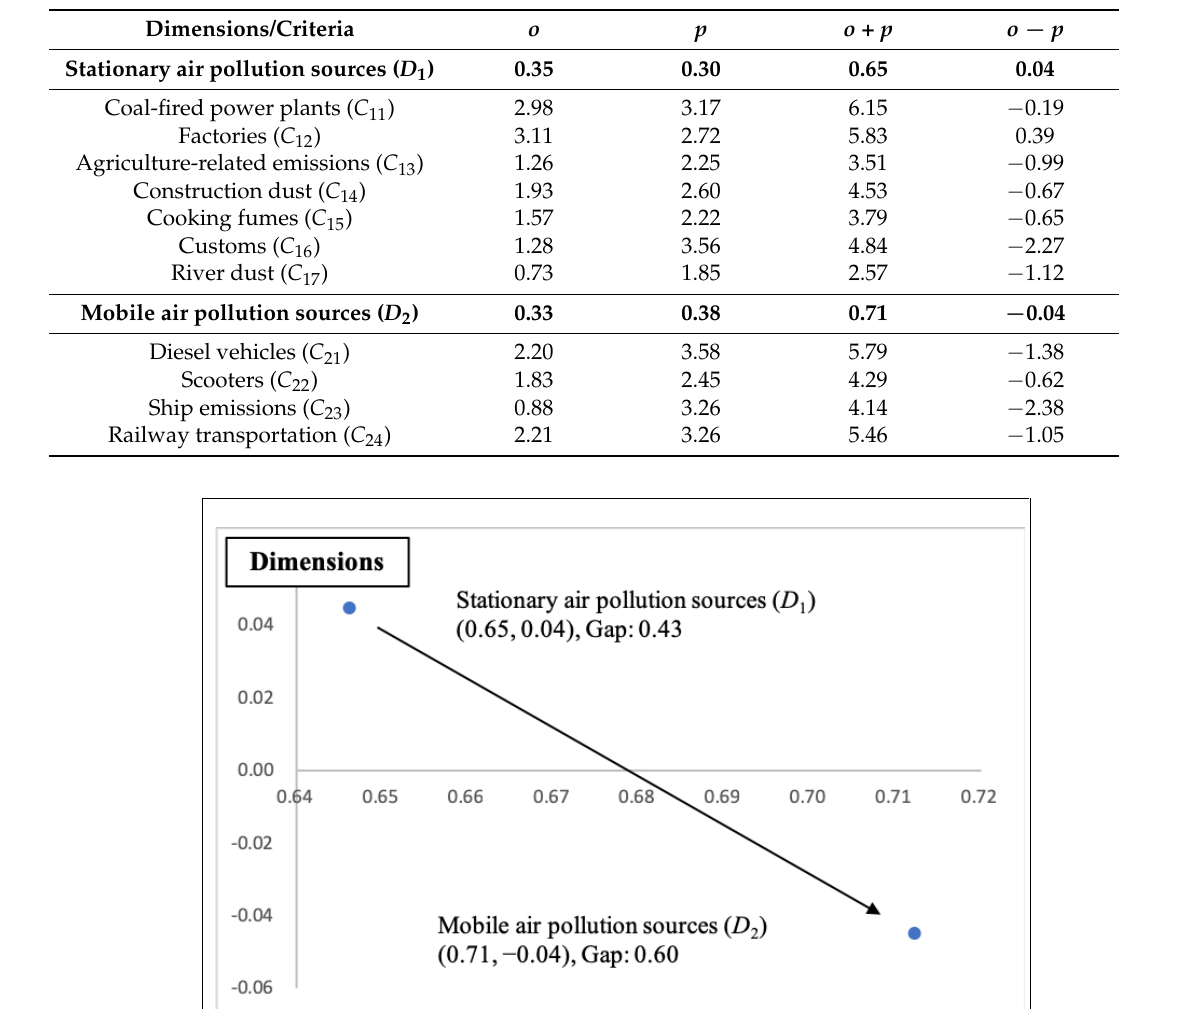
Table 2. Sum of influences given and received for constructing the influential network relation map (INRM).